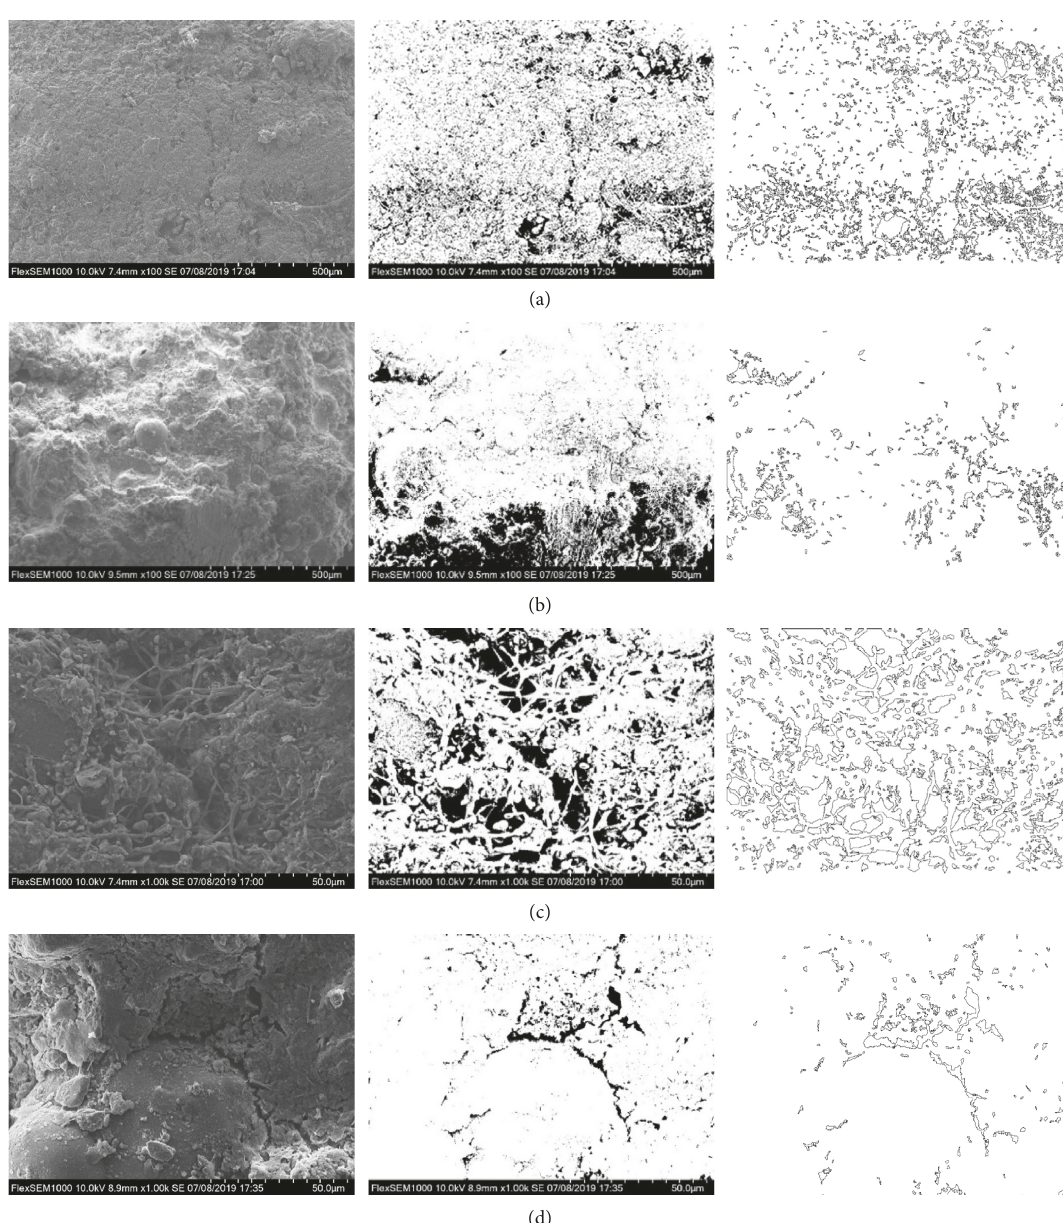
Figure 13: Original and binarization SEM images. (a) Plain soil ( × 100); (b) 10% F+5% L stabilized soil ( × 100); (c) plain soil (x1000); (d) 10% F+5% L stabilized soil ( × 1000).